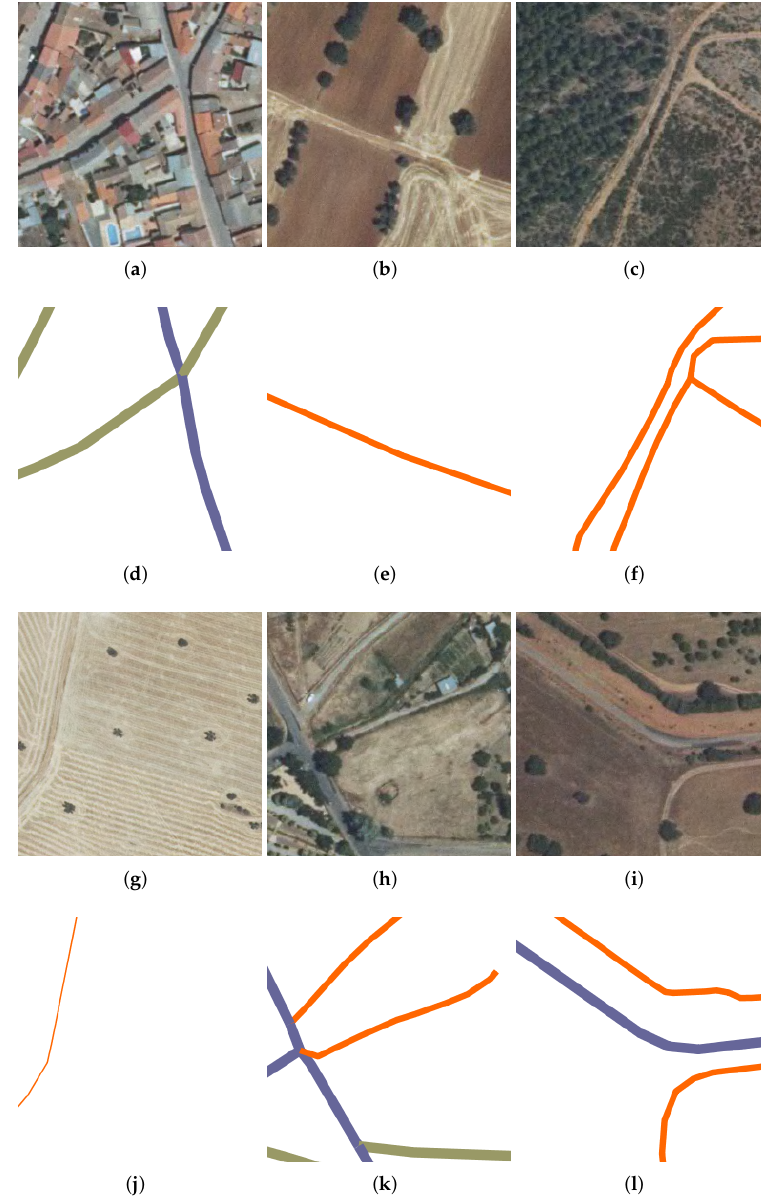
Figure 2. Sample images containing roads ( a – c , g – i ) and their corresponding road cartography ( d – f , j – l